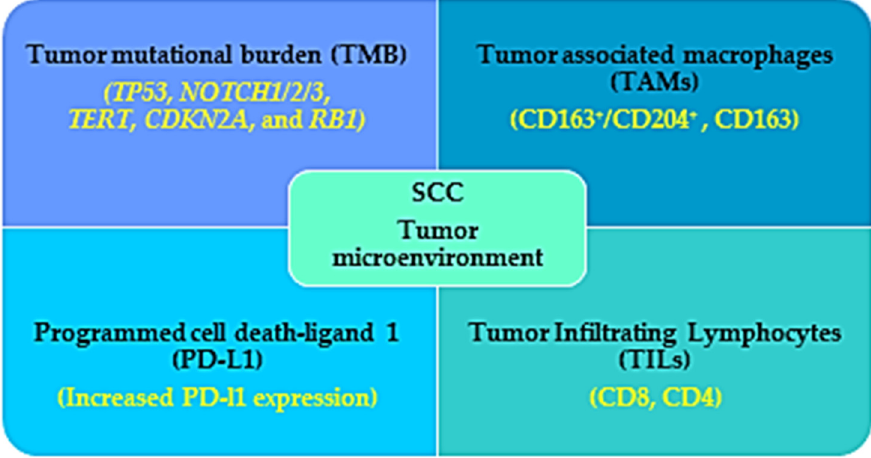
Figure 2. Immunogenic characteristics of SCC that favor the benefits observed in immunotherapy treatment for SCC patients. The tumor microenvironment (TME) of the SCC patients is characterized by high tumor mutational burden (TMB), increased infiltration with tumor associated macrophages (TAMs) and lymphocytes, and increased PD-L1 expression, which work as a favorable prognostic factor for immunotherapy in SCC patients.